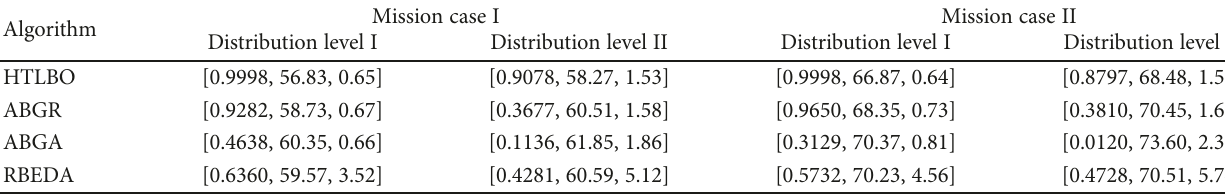
Table 13: Results of the four algorithms (10,000 schedules).